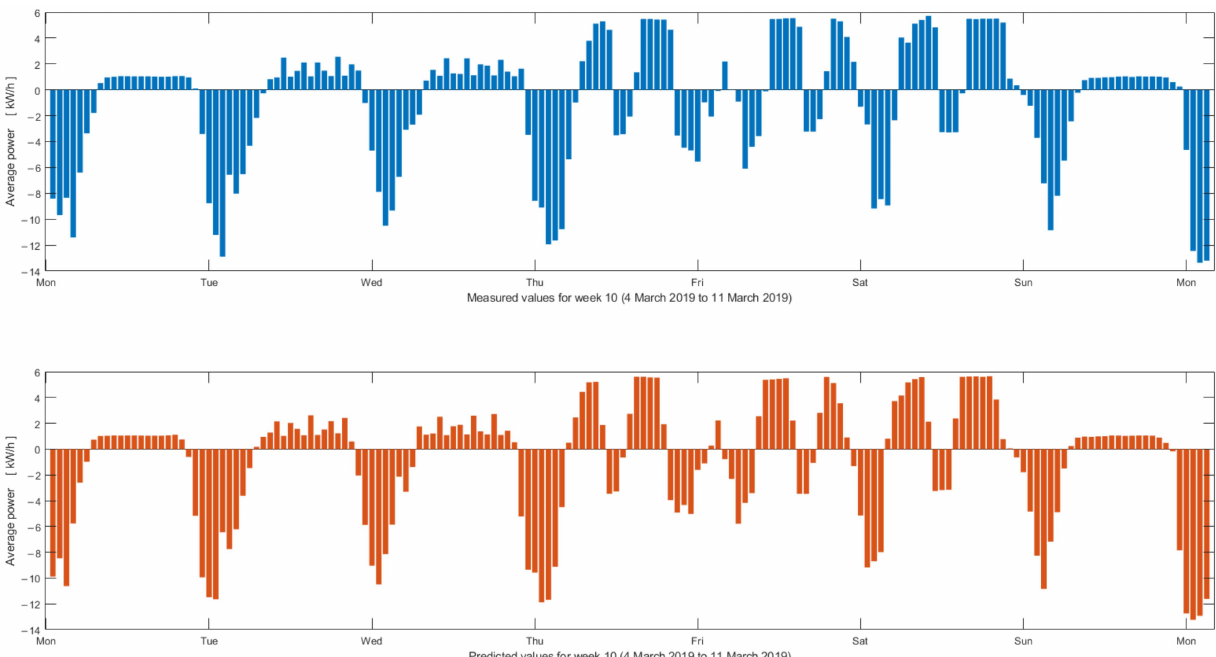
Figure 15. Measured (top—blue) and predicted (bottom—orange) unified electric power production and consumption over week 10 of 2019 (one-hour average electric